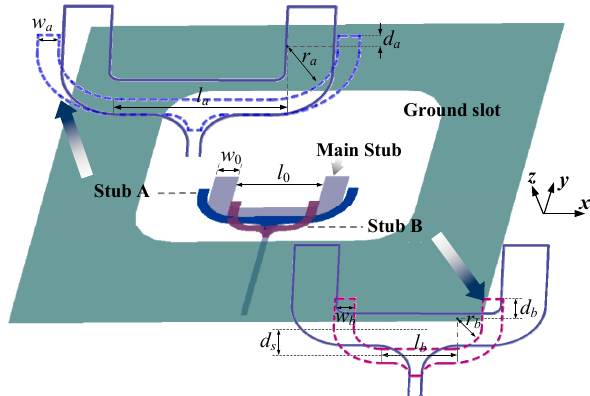
Figure 3. Geometries and configurations of the proposed antennas (adding extra stubs onto the main fork-shaped stub).